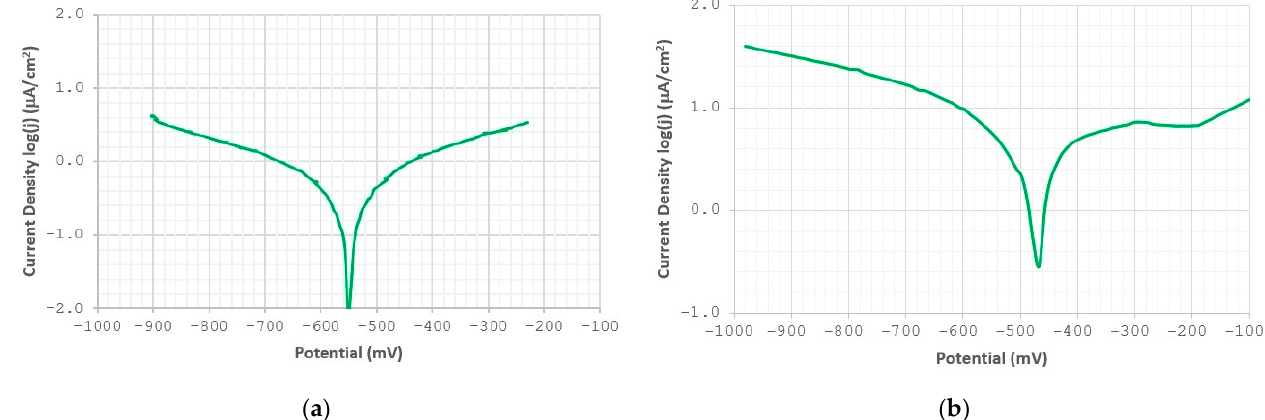
Figure 5. Polarization curves of the tested coatings: ( a ) Cr/CrN PVD, ( b ) gas nitrided with subsequent oxidation and im- pregnation.